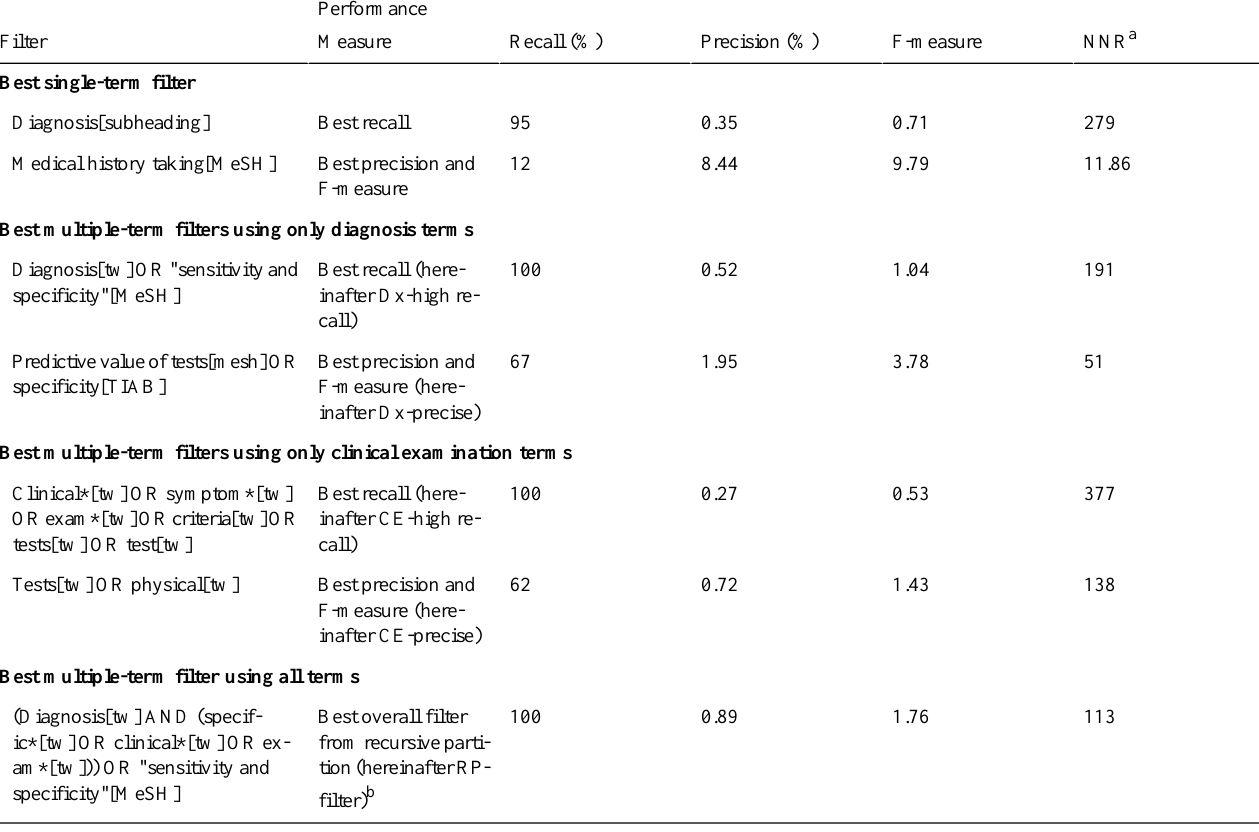
Table 2. Filters with the best recall (keeping fallout less than 50%), precision (keeping recall greater than 50%) and F-measure in the training